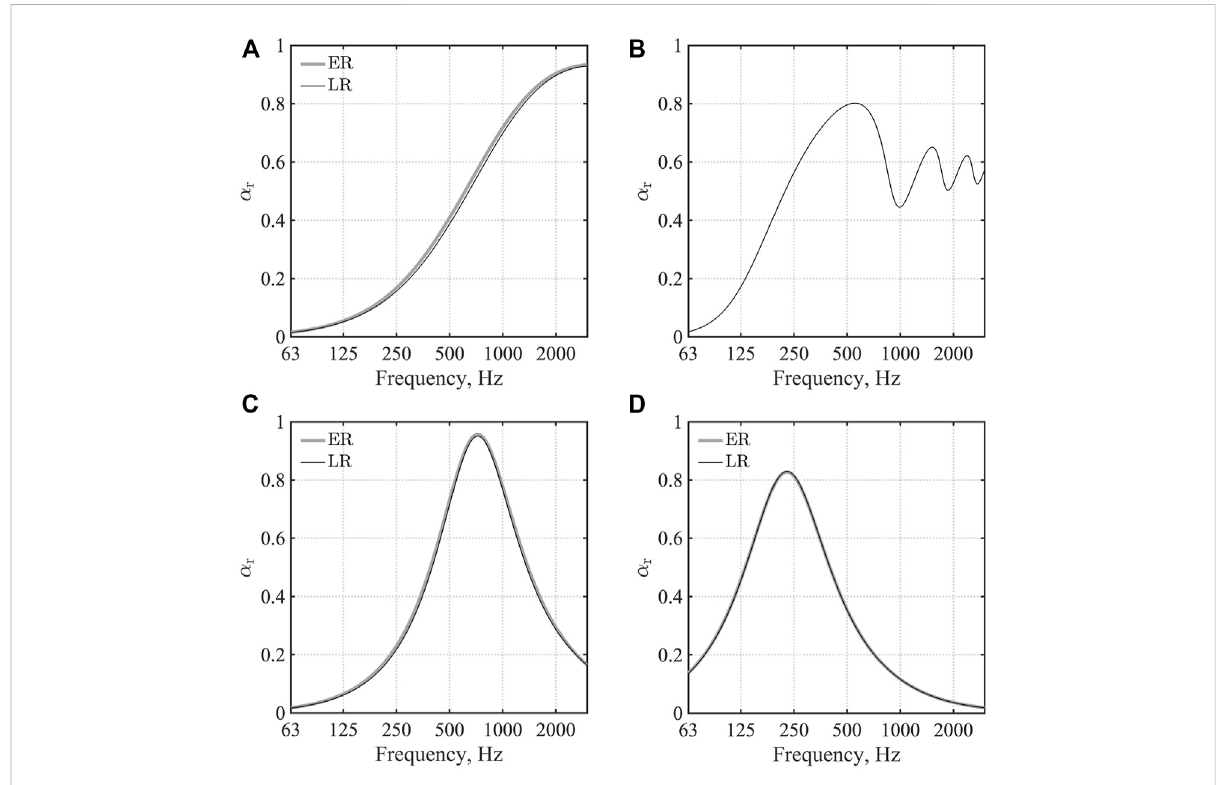
FIGURE 2 Randomincidencesoundabsorptioncoef fi cient: (A) GWceiling; (B) AF; (C) MPPGWpanel;and (D) MPPGWdoor.ERandLRrespectivelydenote extended reaction model and local reaction